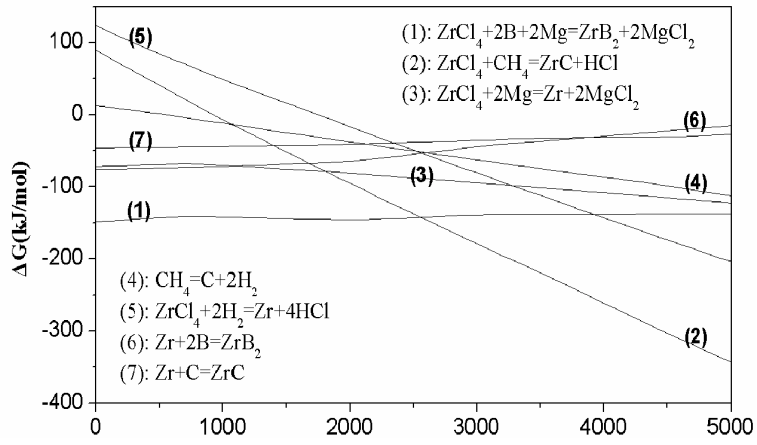
Figure 3. Temperature dependences of the free energy of formation.